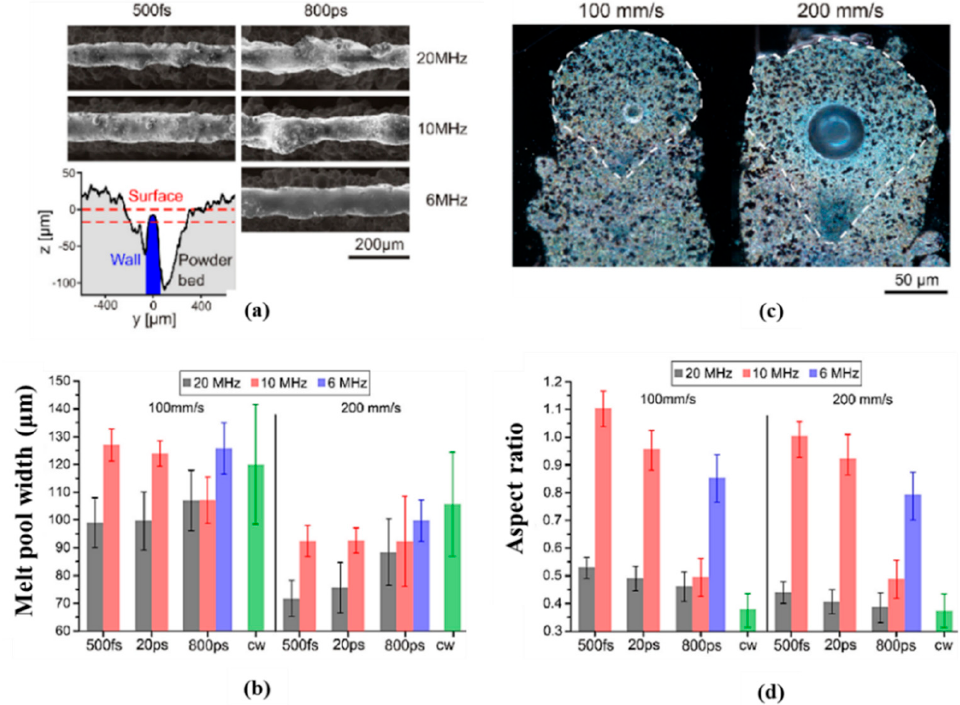
Figure 29. ( a ) SEM images of the tip of wall with a constant scanning speed of 200 mm/s; ( b ) different pulse durations versus melt pool width; ( c ) cross-section of two polished walls at 500 fs and 10 MHz repetition rate; ( d ) different scanning speeds versus aspect ratio [183].